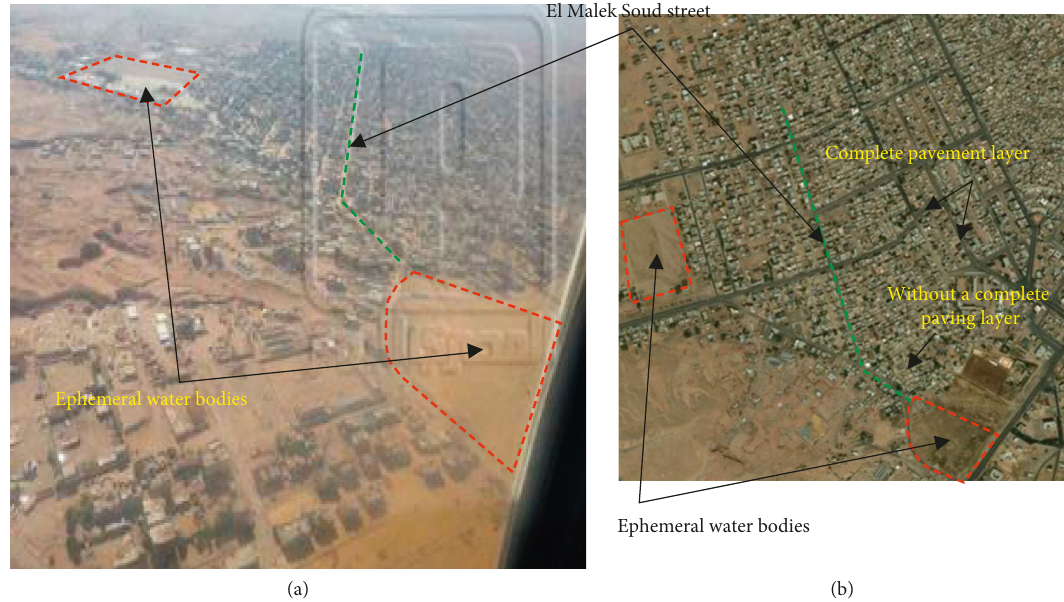
Figure 6: (a) The ephemeral water bodies settled in the lowest area of zone B, and then, the water clearly appeared in the main and substreets. (b) The Google image helps classify streets of complete or partial paving